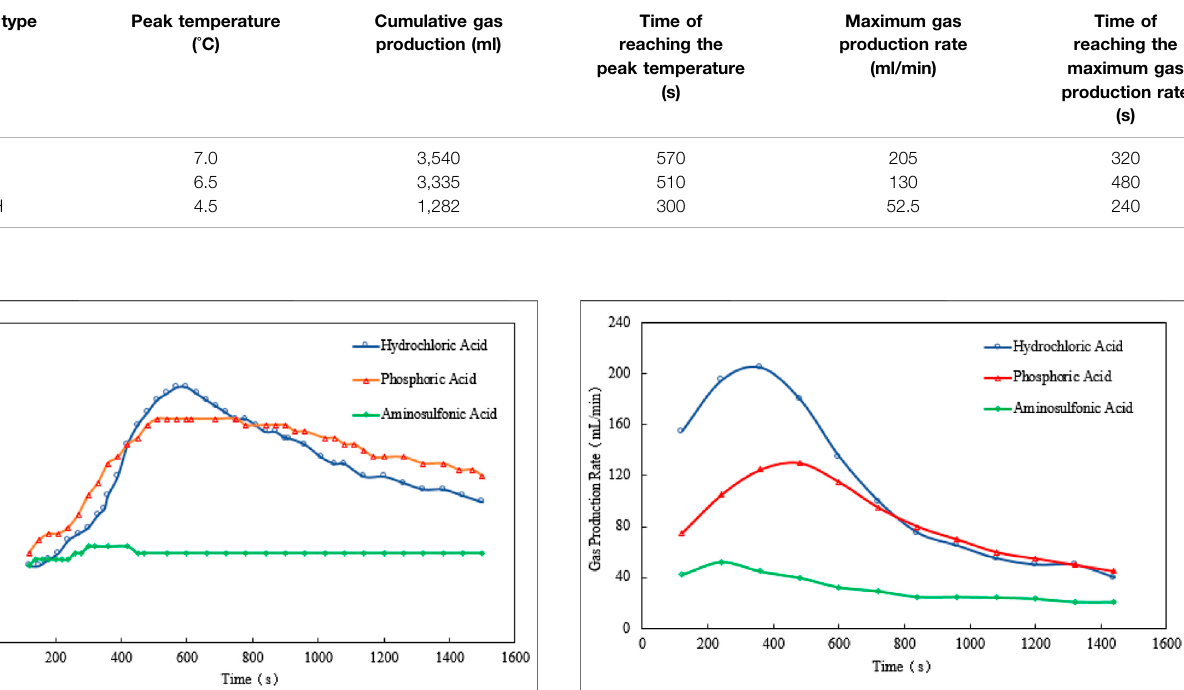
FIGURE 3 | Gas production rate vs. time for different